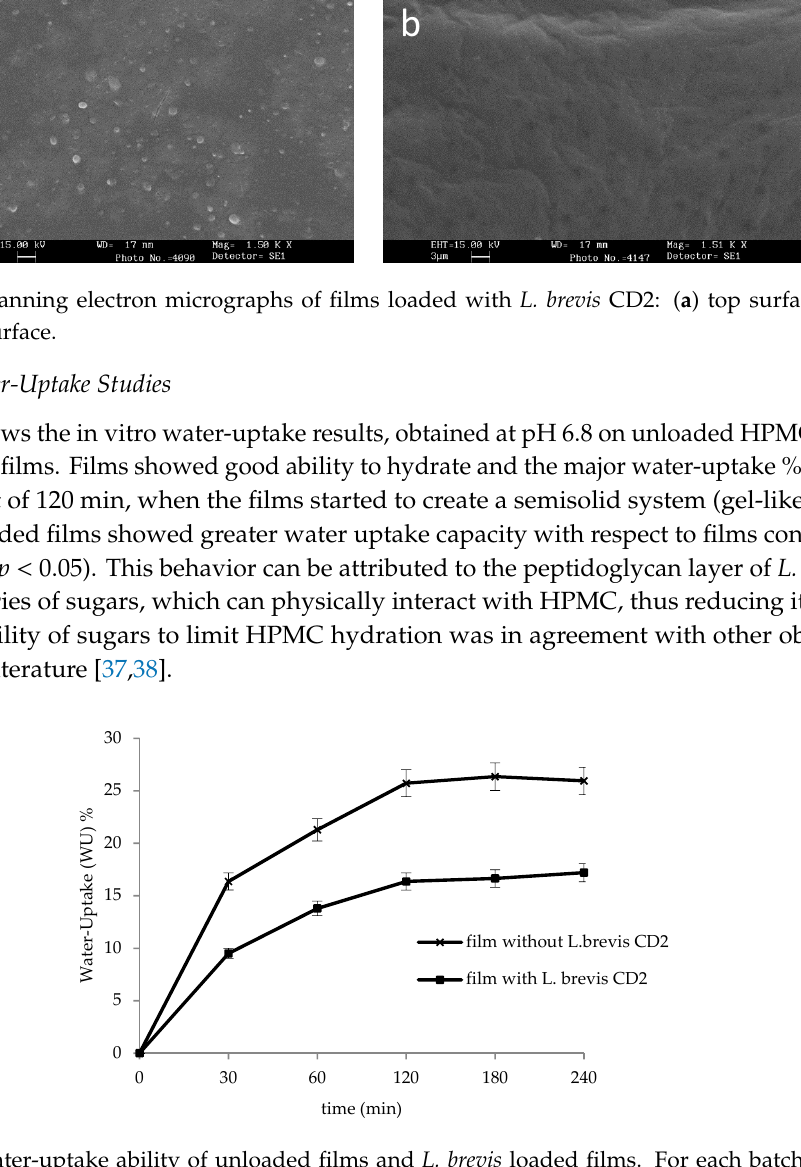
Figure 2. Water-uptake ability of unloaded films and L. brevis loaded films. For each batch, three determinations were carried out. Data reported correspond to the mean of five measurements ± standard deviation.